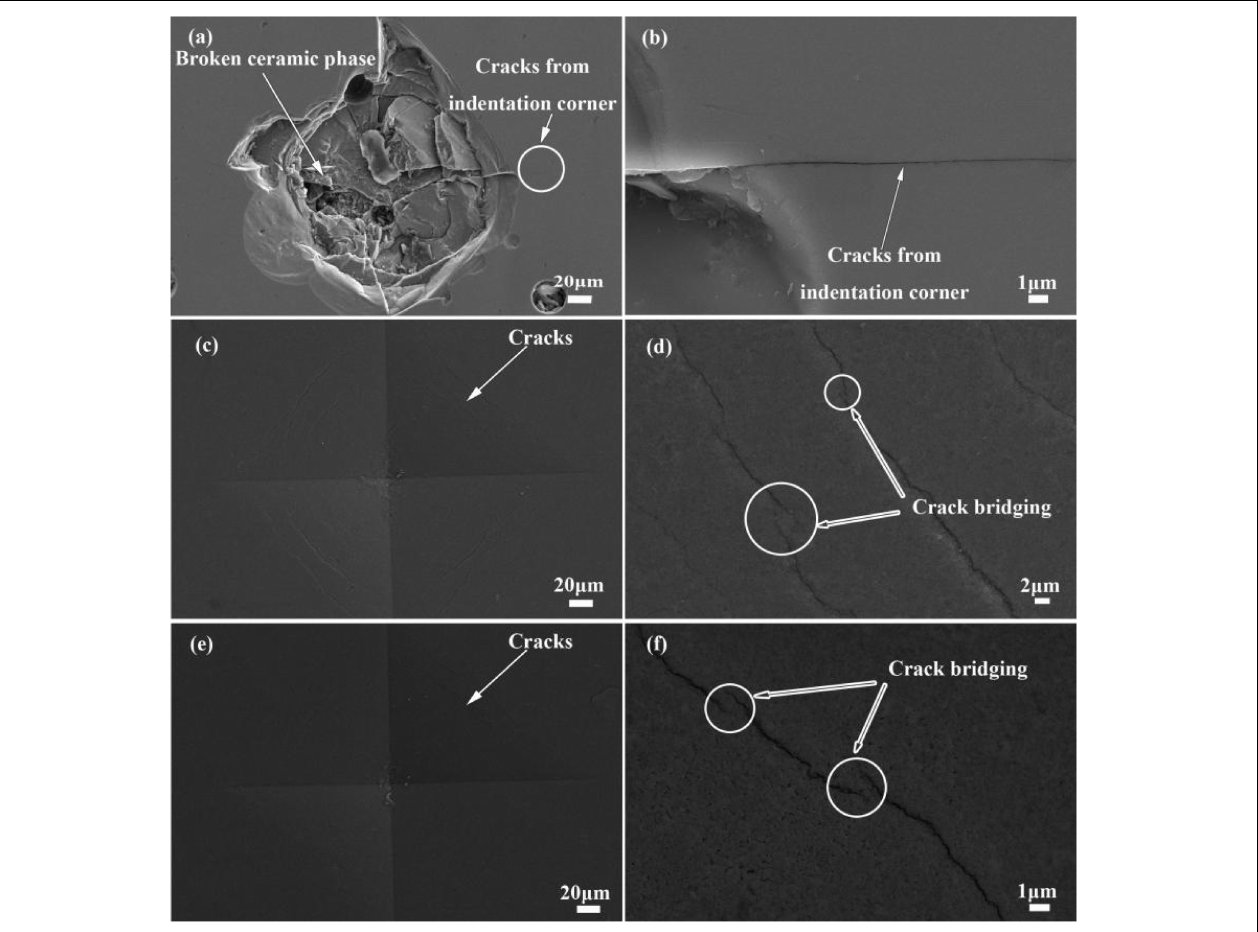
FIGURE 7 | Scanning electron microscope of indentation areas of ceramics and PICNs at an indentation load of 50 N. (a,b) Ceramic, (c,d) PICN BTC, and (e,f) PICN